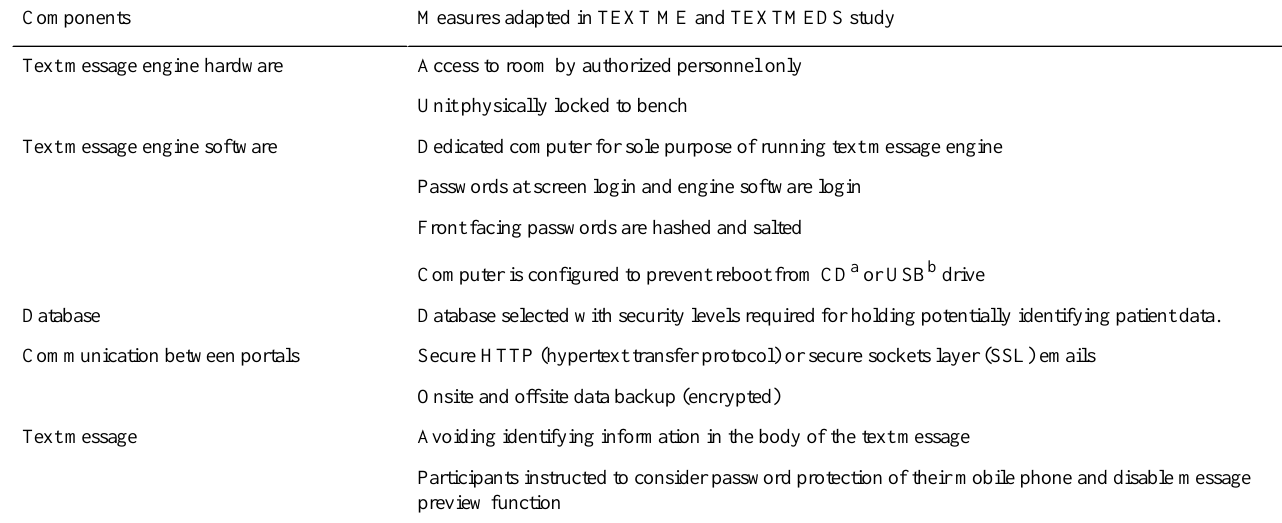
Table 4. Areas at risk of security compromise in a text message study and measures adapted in TEXT ME and TEXTMEDS study. Measures adapted in TEXT ME and TEXTMEDS